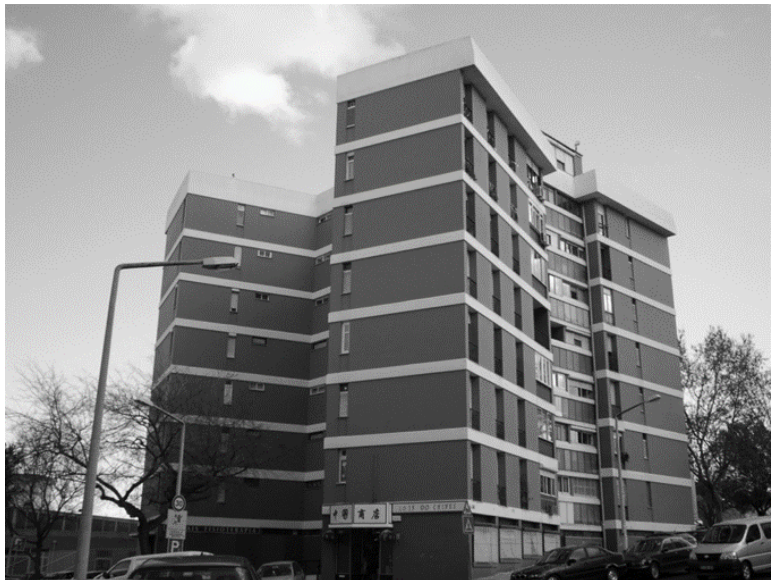
Figure 19. Exterior image.